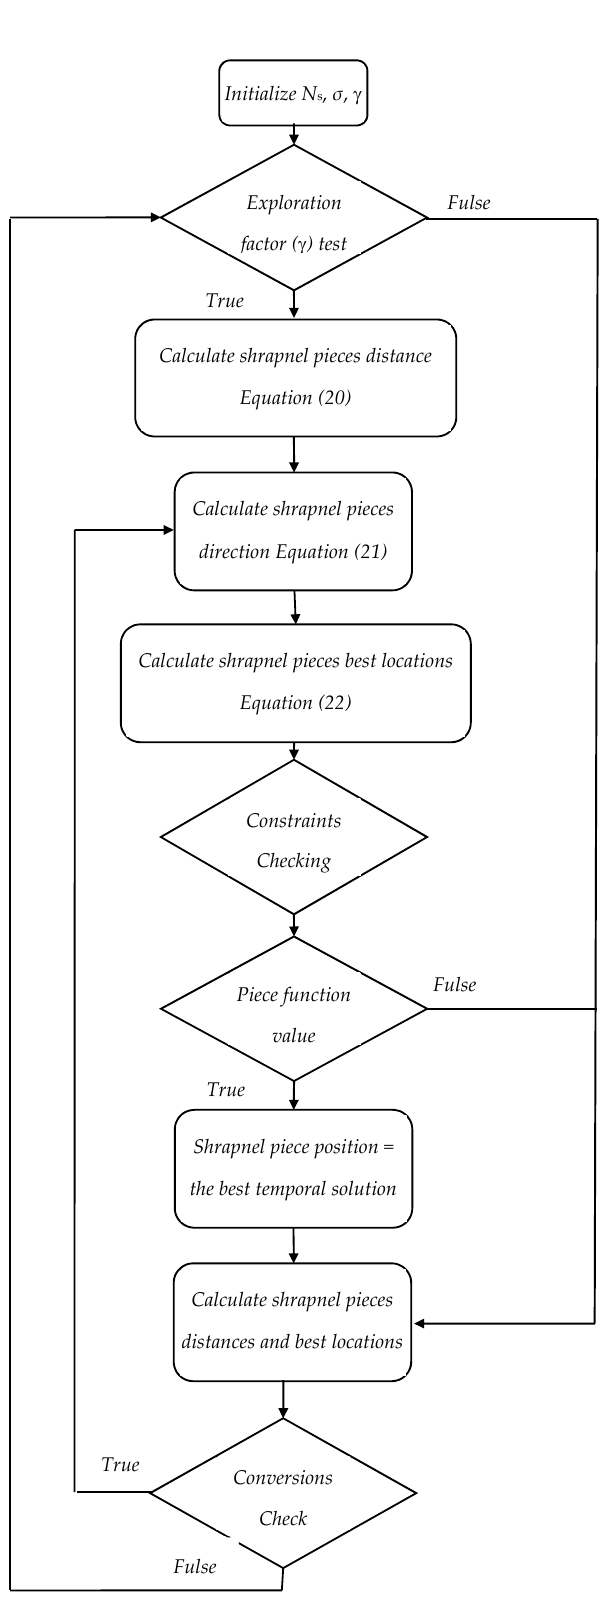
Figure 6. Mine blast algorithm flowchart.